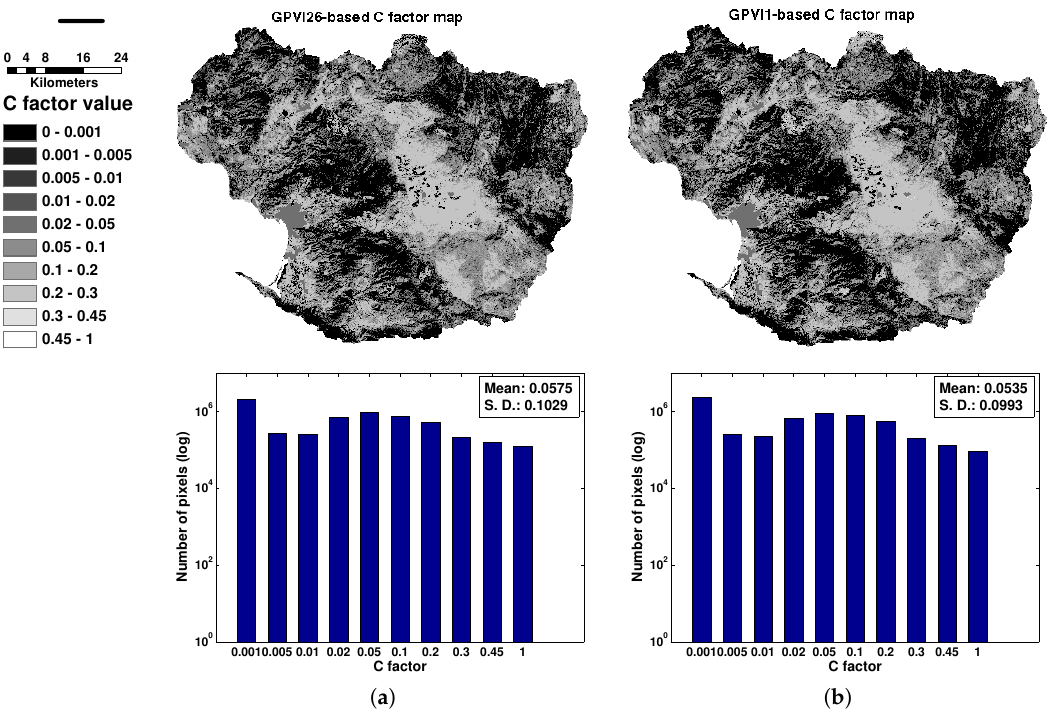
Figure 9. C factor maps produced by the best performing CGPVIs: ( a ) CGPVI26 and ( b ) CGPVI1. The pixel histogram for each map is